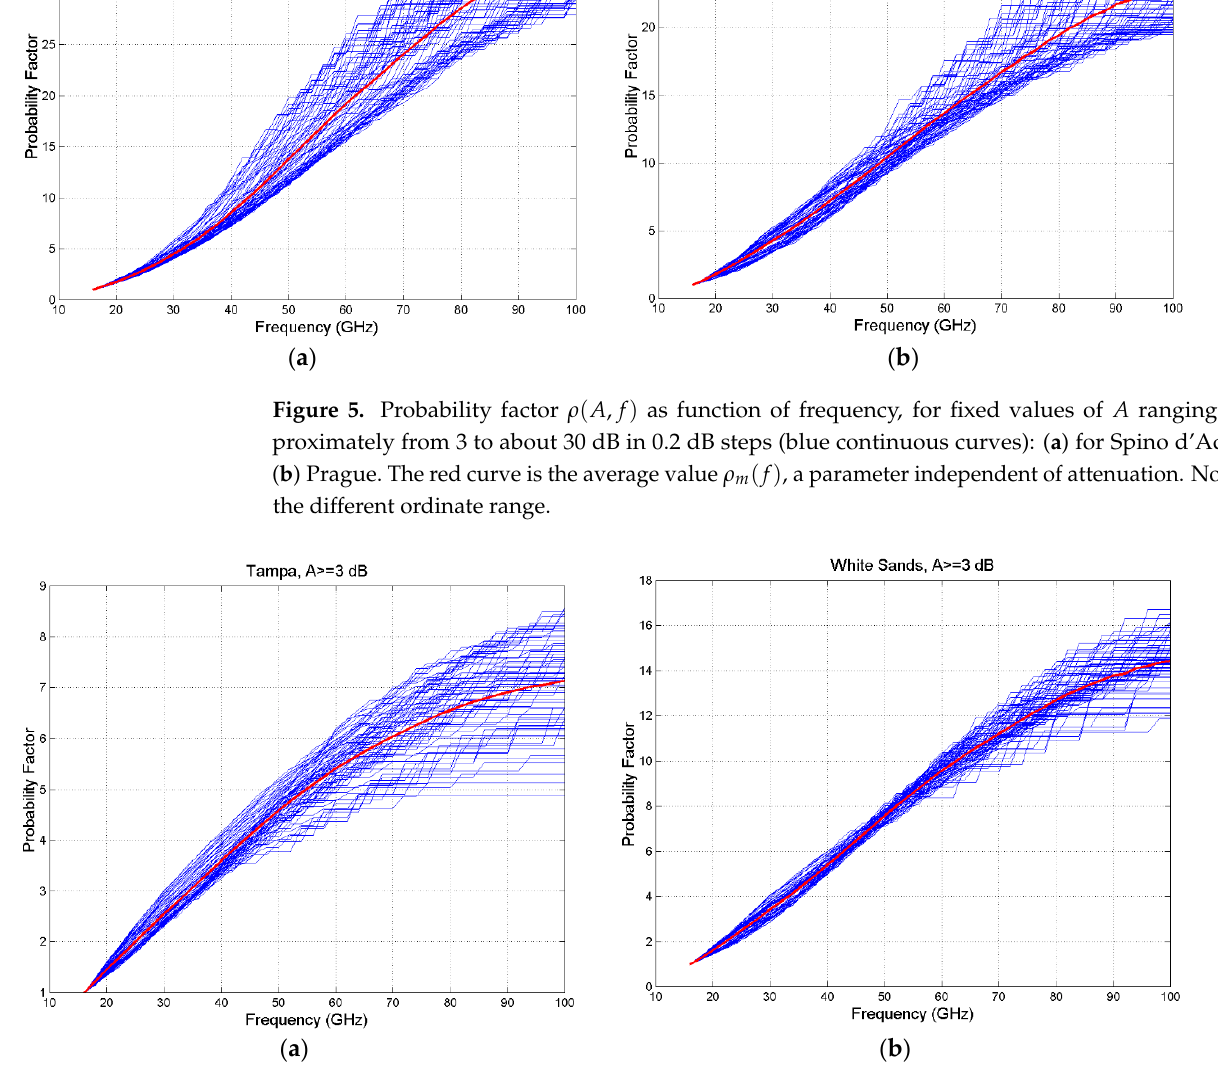
Figure 6. Probability factor ρ ( A , f ) as function of frequency, for fixed values of A ranging approximately from 3 to about 30 dB in 0.2 dB steps (blue continuous curves): ( a ) Tampa; ( b ) White Sands. The red curve is the average value ρ m ( f ) , a parameter independent of attenuation. Notice the different ordinate range.